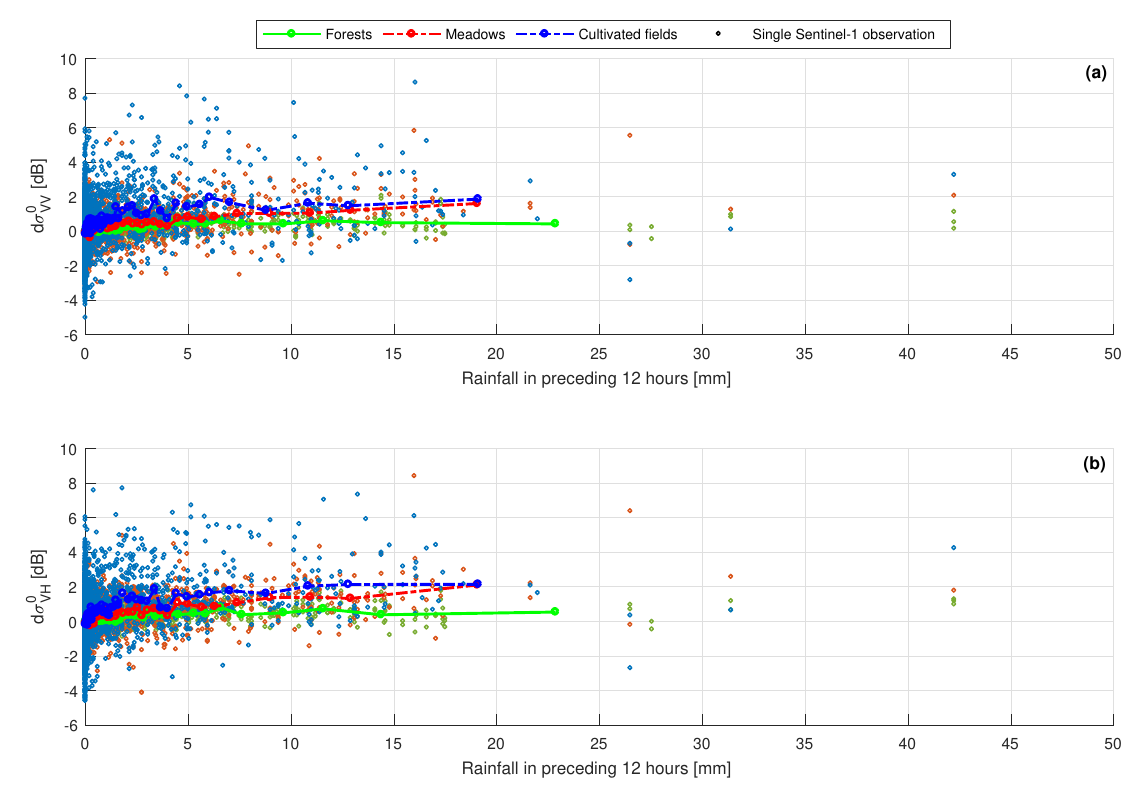
Figure 8. The effect of the rainfall sum in the preceding 12 h on the seasonal anomalies ( d σ 0 ) of the Sentinel-1 σ 0 observations in VV polarization ( a ) and VH polarization ( b ). Each point on the lines represents a bin of 25 Sentinel-1 observations along the x-axis. The Sentinel-1 observations masked for frozen conditions or snow are not